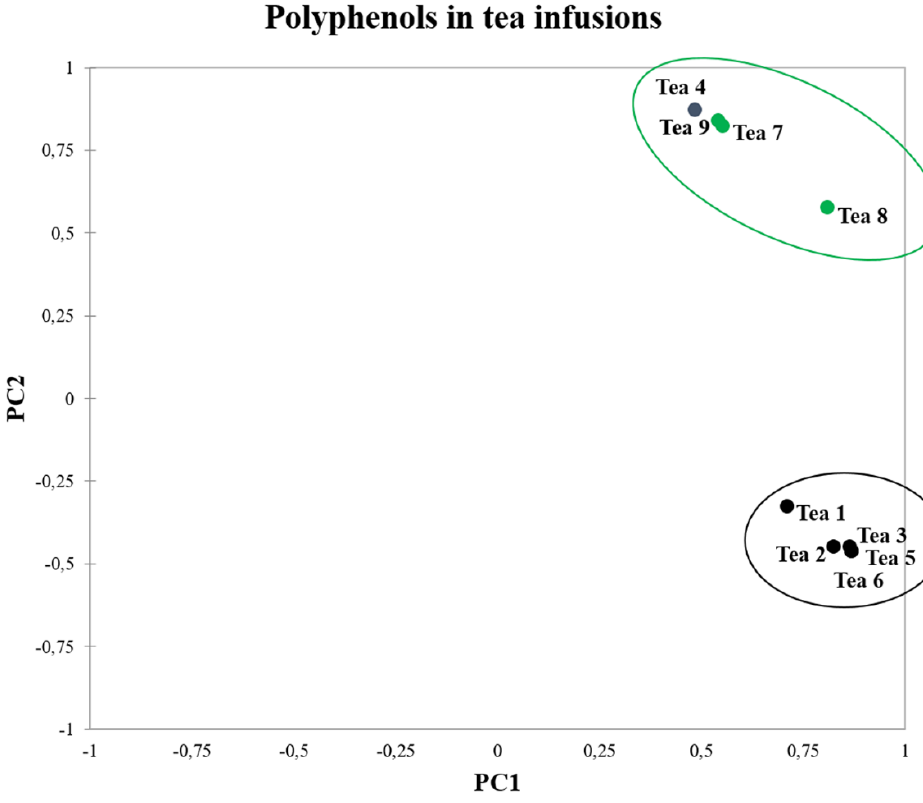
Figure 3. PCA analysis of tea infusions. 1–6 was related to the black teas while 7–9 was of oolong tea and green teas, respectively.